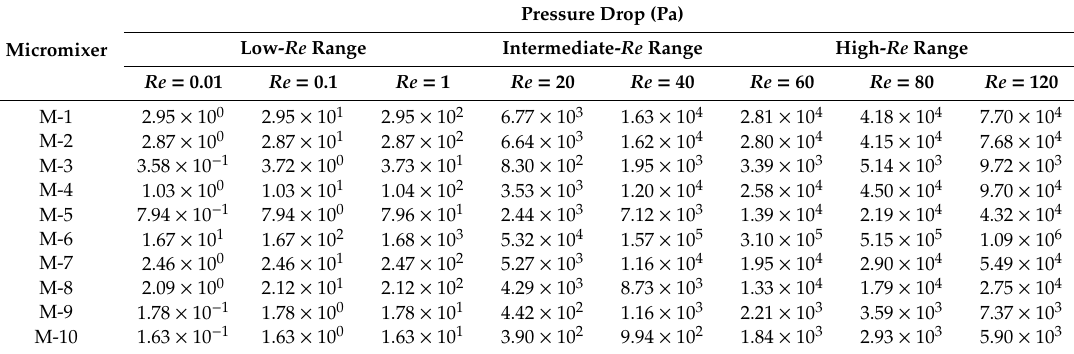
Table 5. Pressure drop through